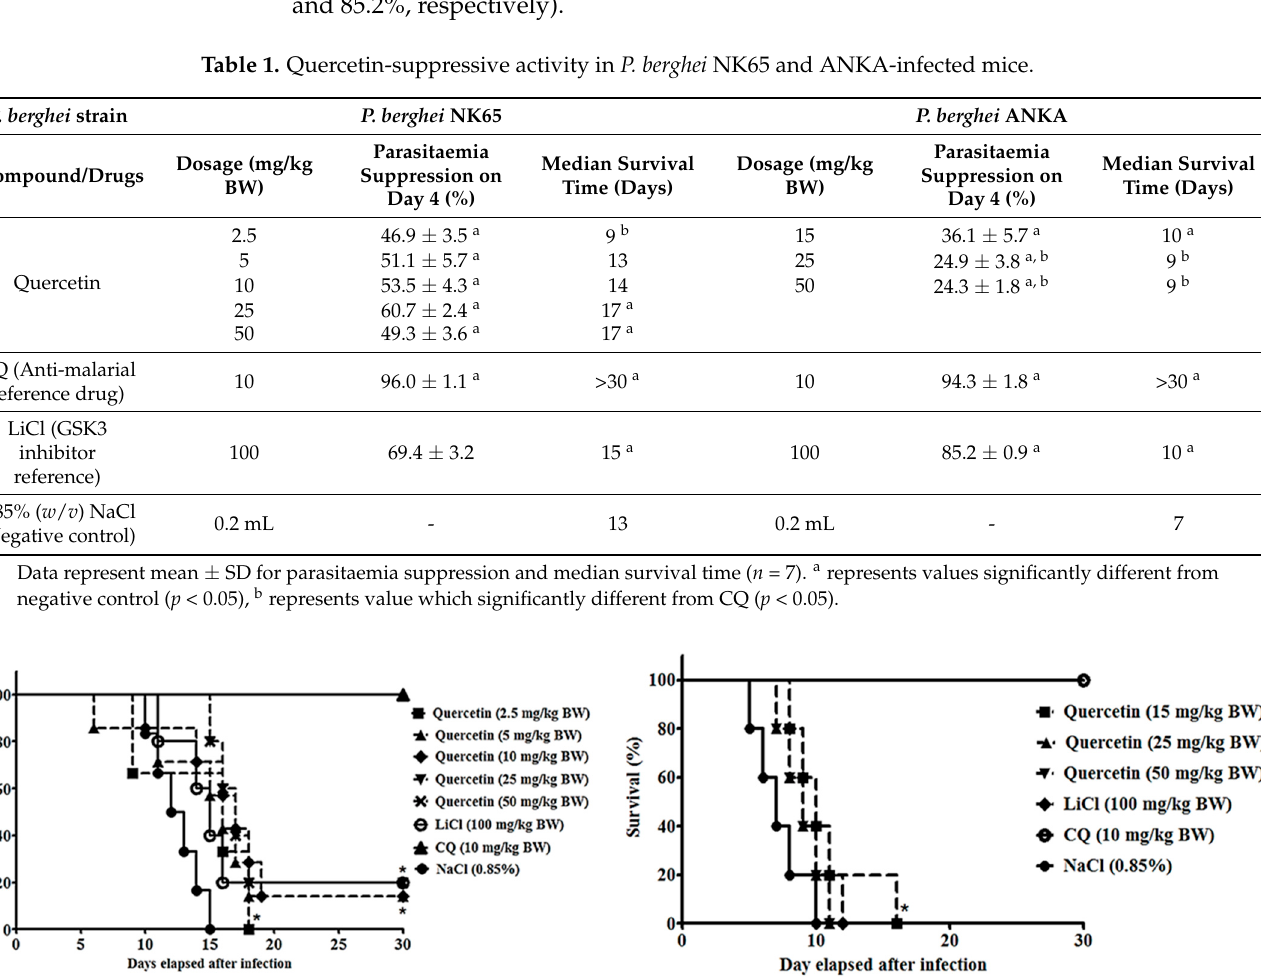
Table 1. Quercetin-suppressive activity in P. berghei NK65 and ANKA-infected mice.